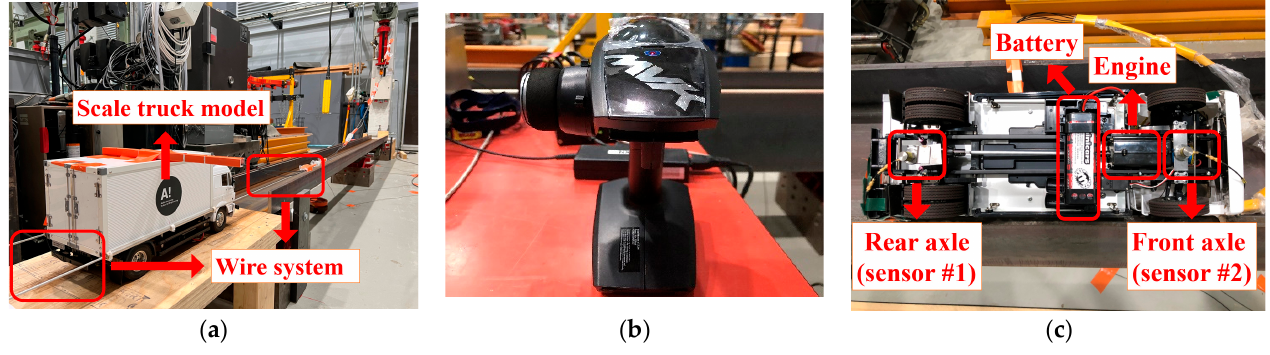
Figure 7. Vehicle model setup. ( a ) Scale truck model, ( b ) Remote controller, ( c ) Sensor installation.